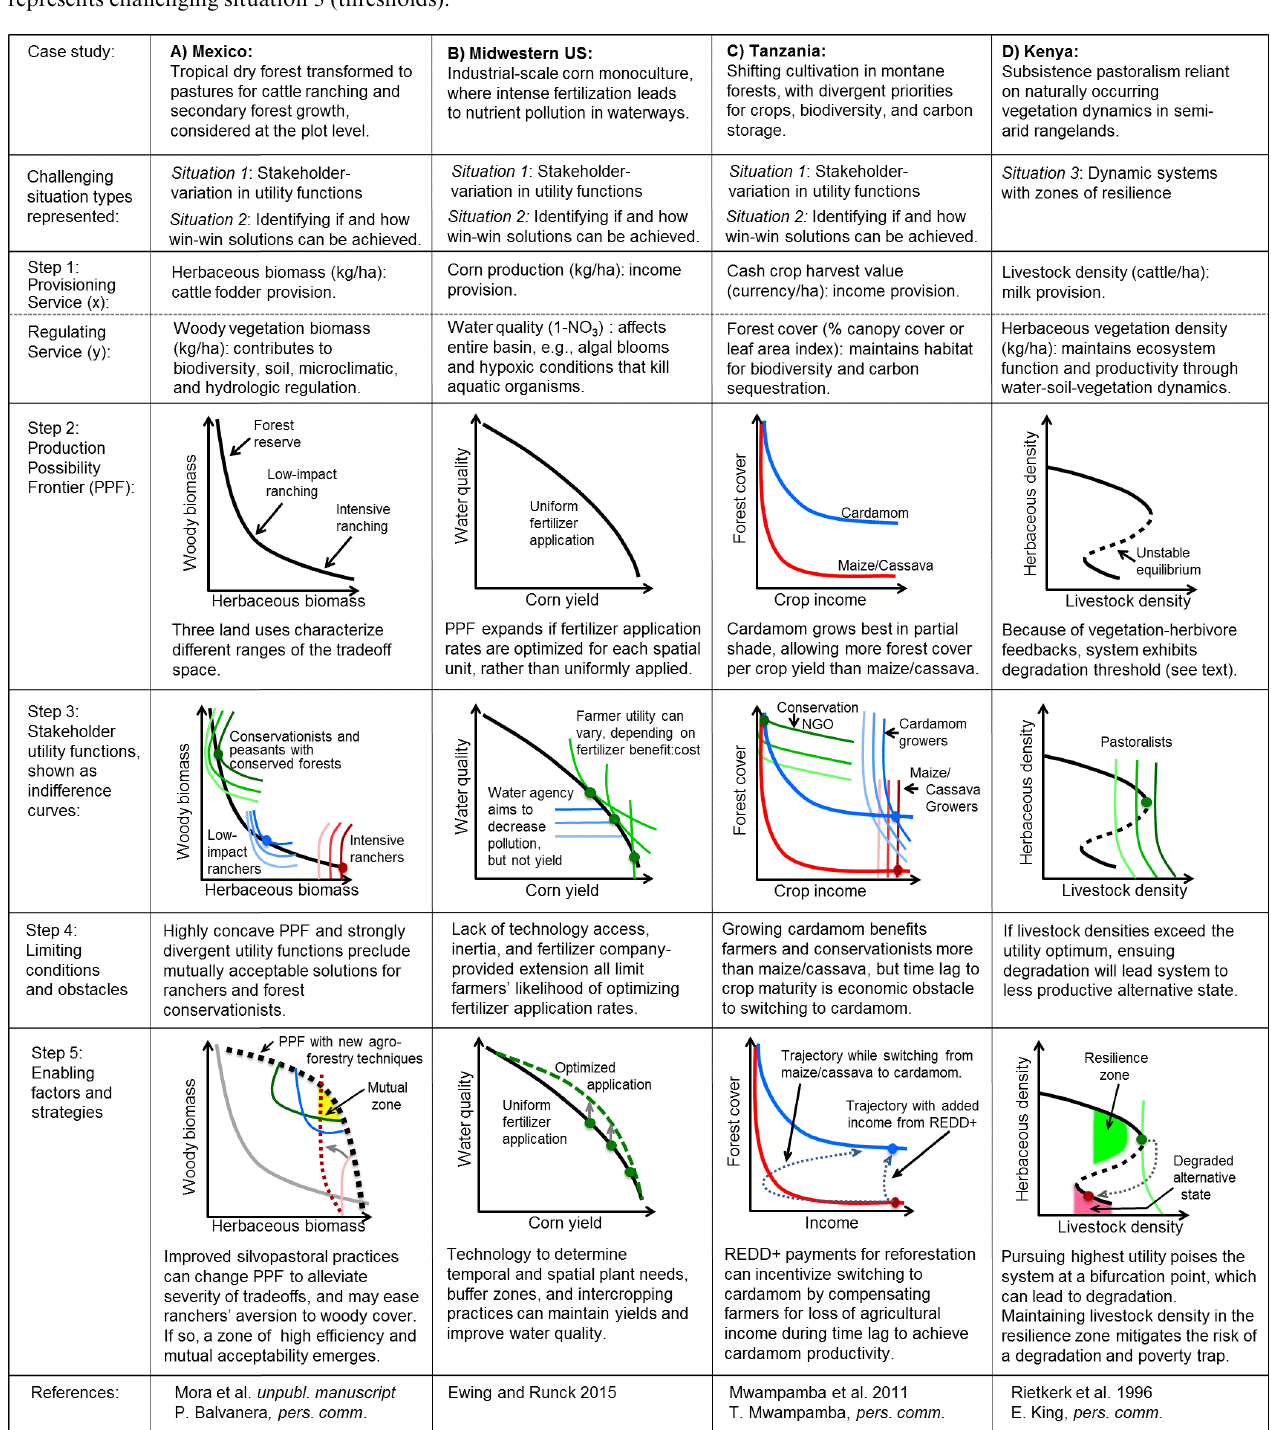
Fig. 2 . Four case studies (columns A-D) of provisioning-regulating service trade-offs explored in the workshop. Each case study was analyzed using the 5-step protocol, as indicated in the left column. Cases A, B, and C provide examples of challenging situation 1 (stakeholder divergence in utility functions) and challenging situation 2 (if and when win-win outcomes can be achieved). Case D represents challenging situation 3